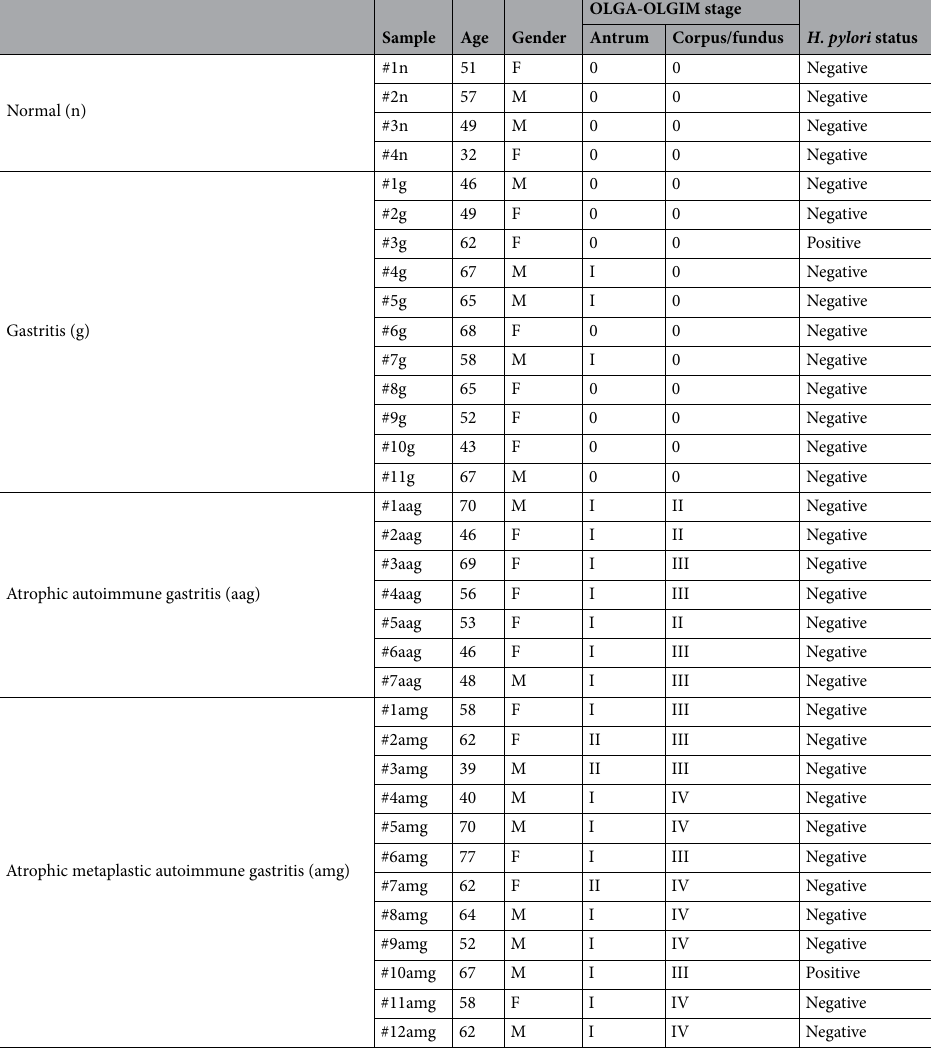
Table 1. Characteristics of gastritis